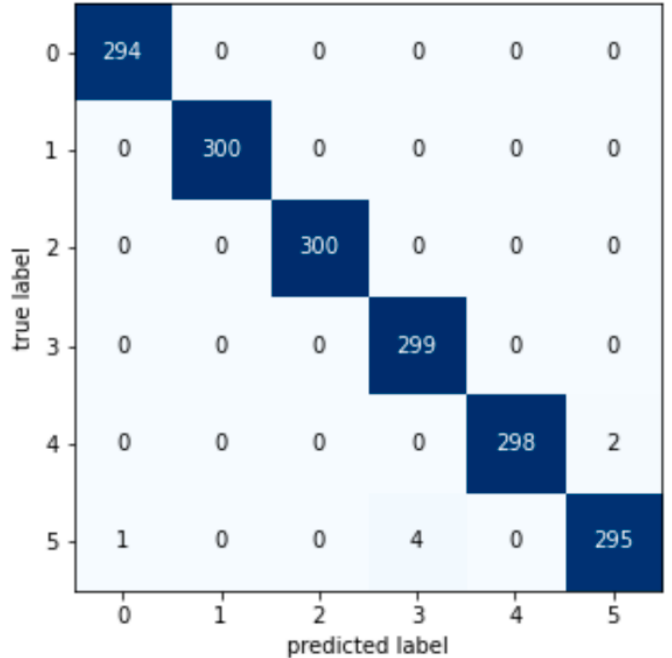
Figure A8. Random forest confusion matrix. More specific model detection results, that is, the evaluation indicators of various machine learning algorithm models and the values of their confusion matrix-derived evaluation indicators, are shown in Tables